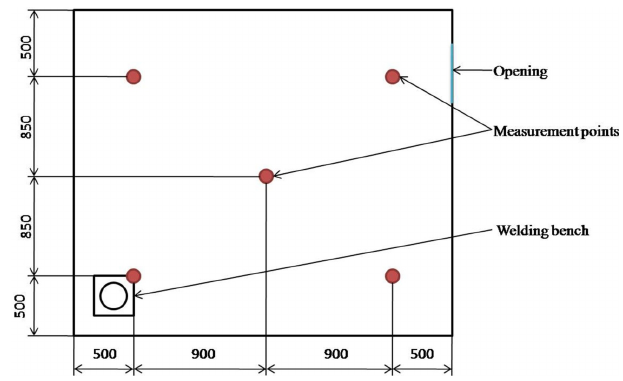
Figure 3. Top view of the model with measurement points.